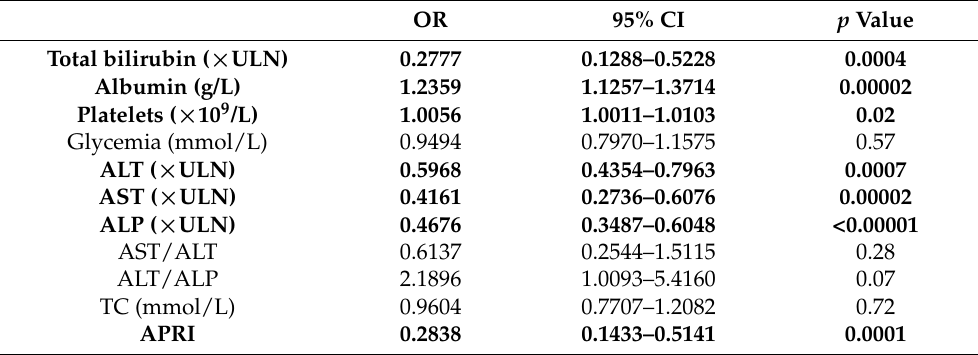
Table 5. Age and sex adjusted associations of pretreatment clinical characteristics of PBC patients with the treatment response after 12 months of UDCA therapy (multiple logistic regression